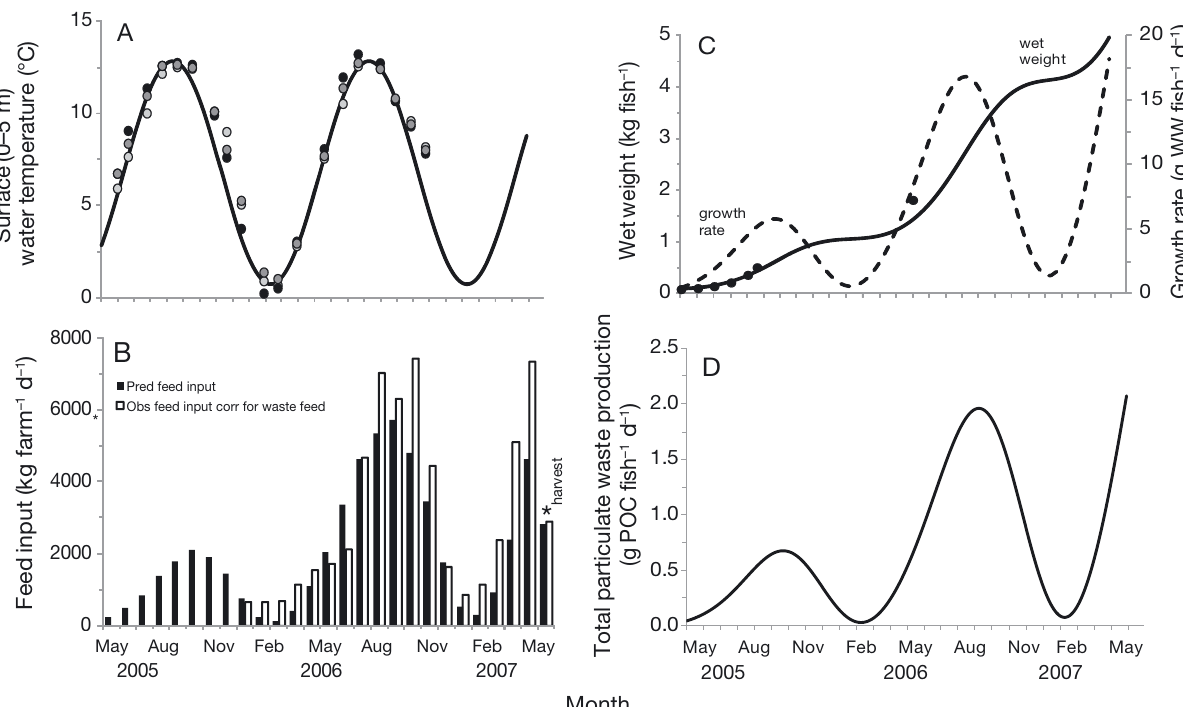
Fig. 2. (A) Variations in surface (0−5 m) temperature in Passamquoddy Bay near Bliss Harbour calculated using a cosine func- tion (Eq. S1 in Supplement 1) (solid line) with annual maximum (12.83°C) and minimum (0.75°C) temperatures. Data from 3 monitoring stations (filled circles) in Passamaquoddy Bay close to Bliss Harbour in 2014 and 2015 (Robinson 2022). (B) Filled bars: predicted feed input required for growth calculated from mass balance coefficients; unfilled: industry reported monthly daily average feed rates from Chang et al. (2014a). (C) Wet weight and daily growth rate calculated using thermal growth and mass-balance coefficients to yield a harvest wet weight of 4.96 kg over 791 d. Filled circles: predicted weight from Peterson et al. (2001) using a Q 10 growth model. (D) Total particulate waste (feces and waste feed) production during the grow-out period based on mass-balance coefficients. Variable input values for Farm A in Table